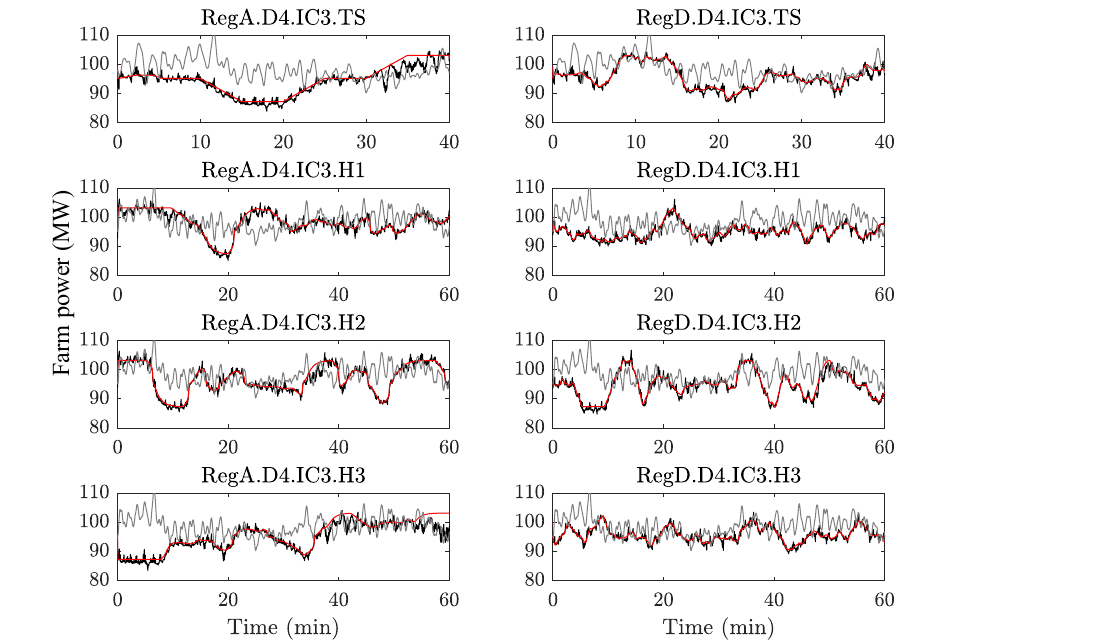
Figure 8. Power tracking performance of dynamic-model-controlled wind farms comparing simulated farm power from a controlled LES wind farm model (black), an uncontrolled LES wind farm model (gray), and power reference signals (red) for 4% derates and initial condi- tion 3.